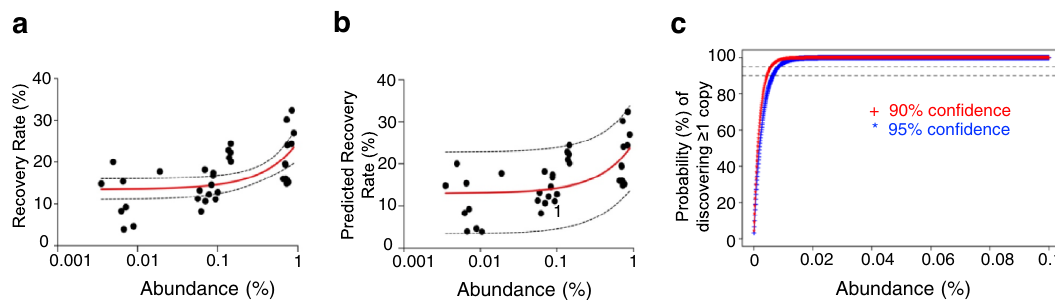
Fig. 4 Determination of the screening ef fi ciency for single-cell platform-based BsAb functional screening, using HEK293_LP CD19/Blin -spiked cell samples. a Scatterplot showing the observed recovery rate versus the abundance of HEK293_LP CD19/Blin spiked in bulk negative cells (one million HEK_LP CD19 ). The recovery rate isde fi ned as the isolated copy numberdivided by the total copy numberinitially spiked into a sample. Each datapoint ( “ dot ” ) is derived from the mix of n ¼ 3 analytical replicates of spiked samples. The solid red line is derived from linear regression with one standard deviation bounds (dotted lines). b Predicted recovery rate based on a linear regression model and its 90% con fi dence interval ( R 2 = 0.34; p -value = 0.0002; statistical assumptions largely ful fi lled, e.g., stable residual variance). c Prediction of screening ef fi ciency ( “ P ” ), de fi ned as the probability of discovering ≥ 1 copy of a positive clone from a cell pool. This model is based on a binomial probability, where the Bernoulli probability “ p ” refers to the predicted recovery rate in the foregoing regression model, corresponding to a selected con fi dence lower bound (90%-solid red line or 95%-solid blue line).